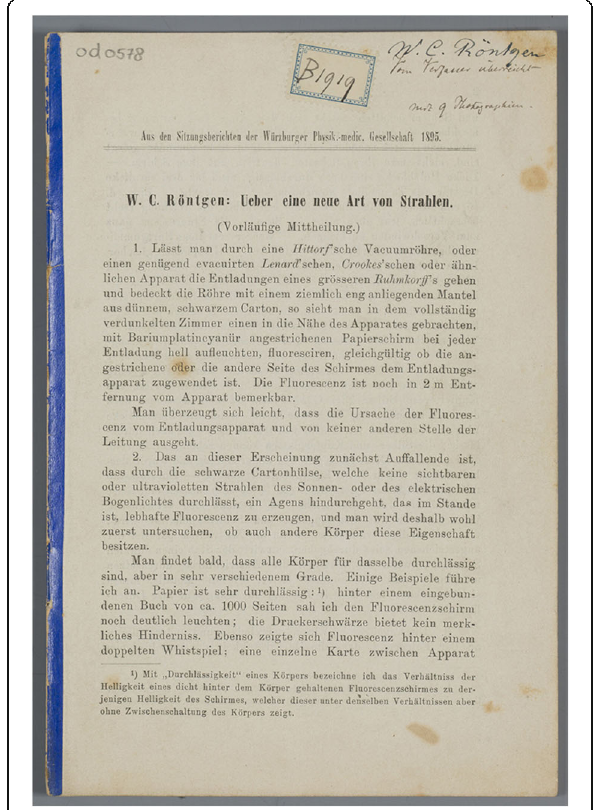
Fig. 2 Reprint of the first publication by Roentgen on his discovery of a new kind of rays. This is the reprint with the blue rim on its spine that was sent to